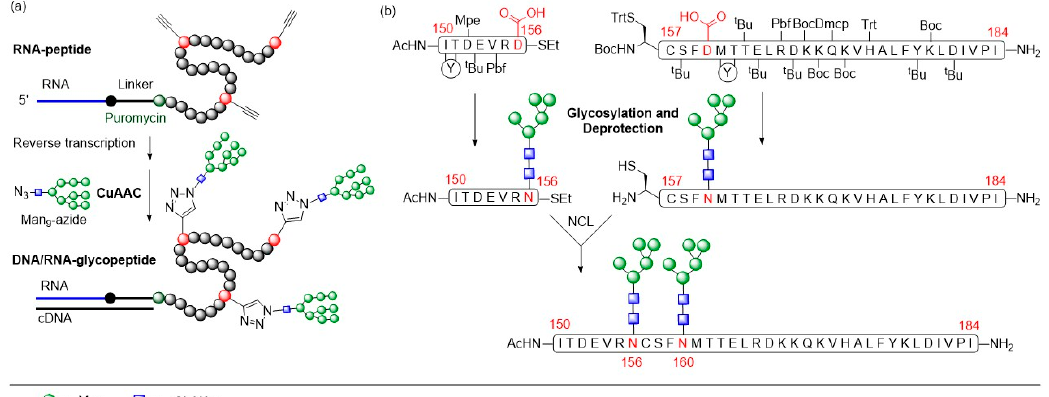
Figure 12. ( a ) Generation of a mRNA-displayed glycopeptide library of ~10 13 sequences; ( b ) of V1V2 glycopeptides using aspartylation and native chemical